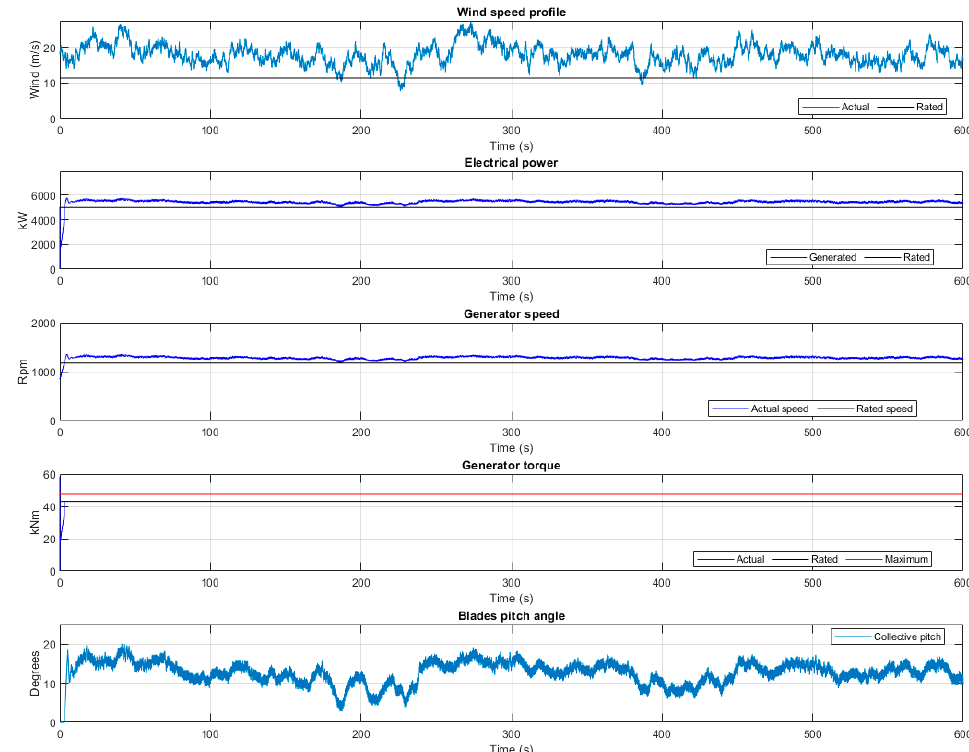
Figure 10. Simulation for reference PI with the Fuzzy Supervisor Control, under a wind profile of average speed of 18 m/s and turbulence A.